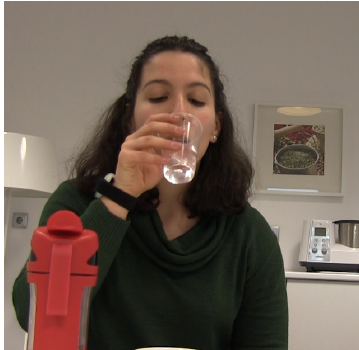
Figure 1. Example of typical IMU placement on the forearm and fluid